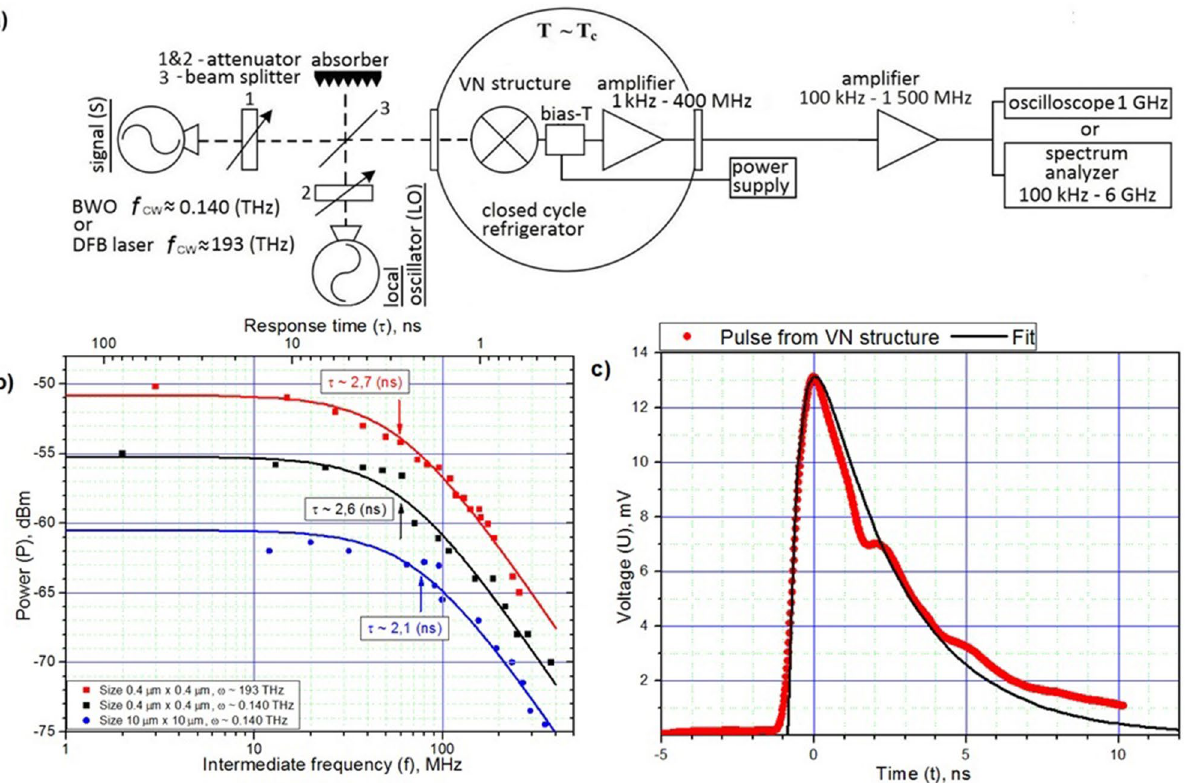
Figure 2. ( a ) An experimental setup for measuring the energy relaxation time of electrons in the VN structures under sub-THz or IR radiation. The energy relaxation time is measured in the mode of mixing of two radiation sources: in the sub-THz range, using backward wave oscillator (BWO) with radiation frequency near ω ≈ 0.140 THz; in the C-band IR range, using DFB lasers with a radiation frequency near ω ≈ 193 THz. ( b ) The values of the output power (P) with the VN structure depending on the intermediate frequency (f) when exposed to low-intensity high-frequency radiation with a frequency of (ω ≈ 193 THz) and (ω ≈ 0.140 THz), respectively. Black and red squares correspond to measurements on the sample with the dimensions of the sensitive region 0.4 μm × 0.4 μm; blue circles correspond to measurements on a sample with a sensitive region of 10 μm × 10 μm. All data were obtained at a temperature close to critical (in the neighborhood T c ). Cutoff frequency (f 3dB ) and the corresponding energy relaxation time (τ) were: ≈ 59 MHz, τ 193 THz ≈ 2.7 ns; f 0.140 THz ≈ 61 MHz, τ 0.140 THz ≈ 2.6 ns for sample with dimensions f 193 THz 3 3 dB dB 0.4 μm × 0.4 μm, and f 0.140 THz 3 dB ≈ 76 MHz, τ 0.140 THz ≈ 2.1 ns for sample with dimensions 10 μm × 10 μm, respectively. For a unifying representation of all three curves on the graph, a scale factor is introduced along the power axis. c) The digitized waveform (red dots) of electrical voltage pulse from the VN structure when exposed to infrared pulses. The duration of the IR pulses was < 45 ps. The black curve is an approximation curve of the form ~ A·exp(−